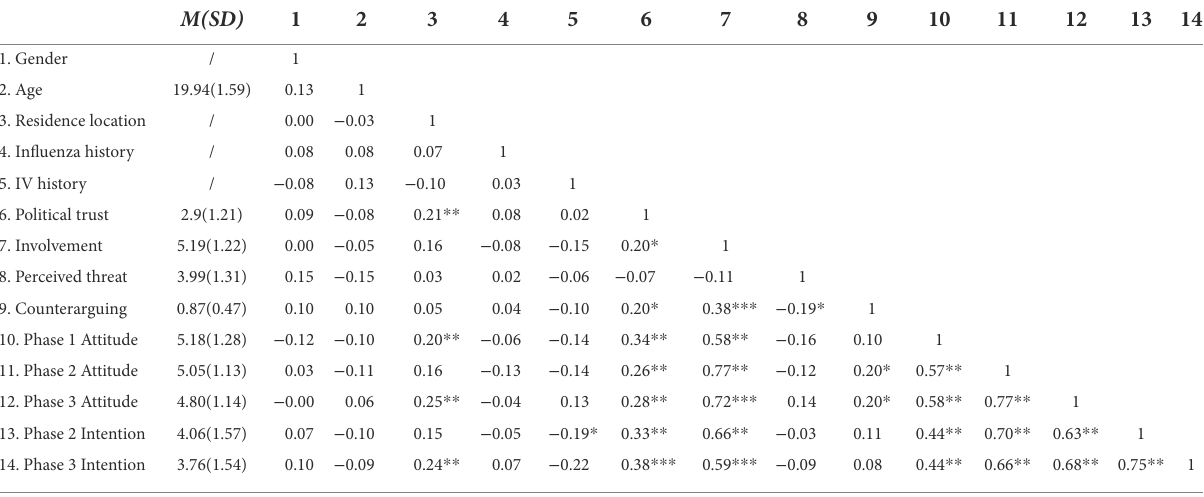
TABLE 1 Zero-order correlation matrix of the variables.